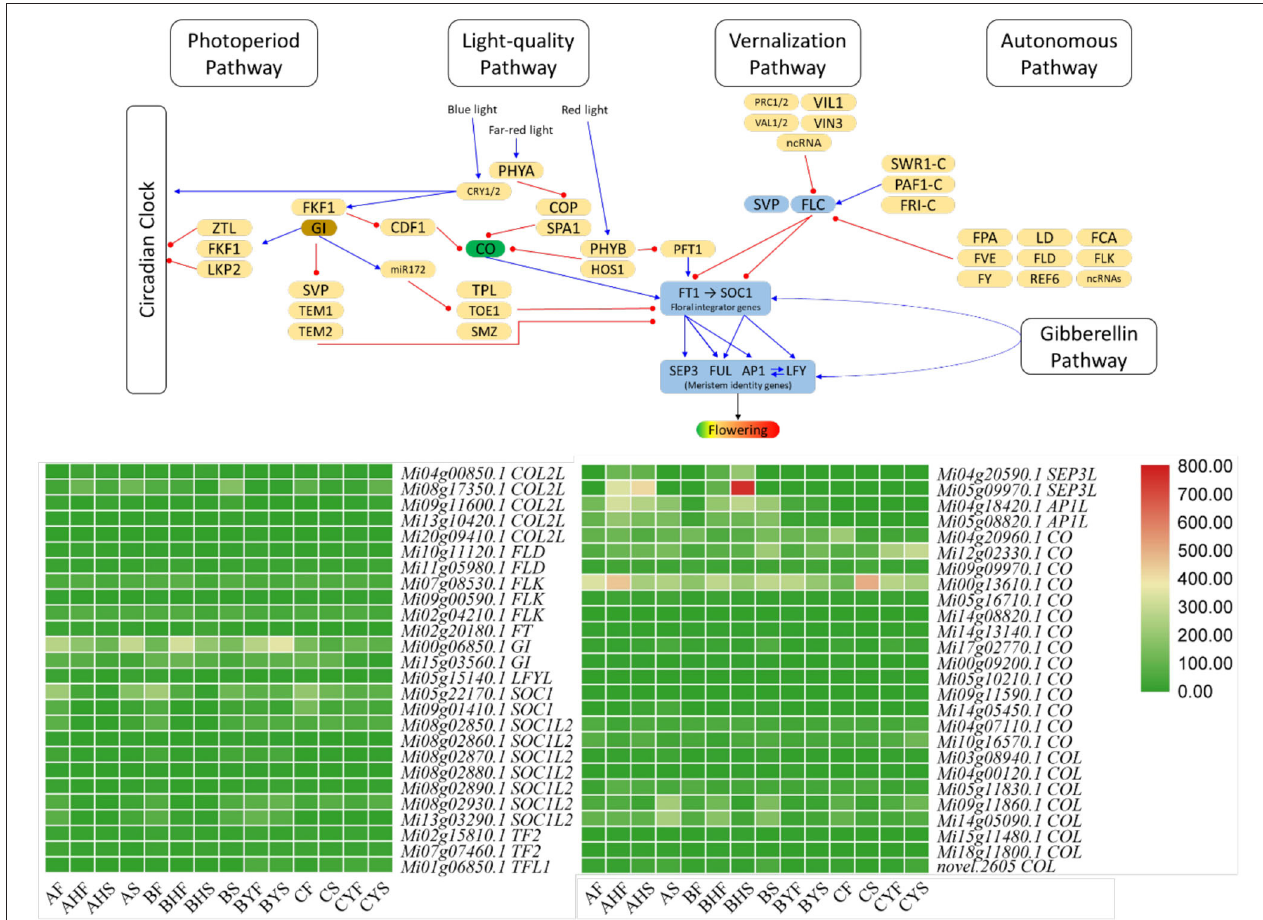
FIGURE 3 | Flowering pathway in Mango. The heatmaps represent FPKM values of the major flowering-related genes, i.e., SEP3L (SEPALLATA3 like), APIL (AP1 like), CO (CONSTANS), COL (CONSTANS like), FLD (Flowering locus D), FT (Flowering locus T), LFYL (LEAFY like), GI (GIGANTEA), FLK (Flowering locus K), SOC (SUPRESSOR OF CONSTANS), SOCL (SOC like), TF (TERMINAL FLOWER), and TFL (TF like). The pathway figure was modified from the study of Kim (2020). The blue arrows show activation, while the red arrows show suppression. The expression of other genes in these pathways is presented in Supplementary Table 2